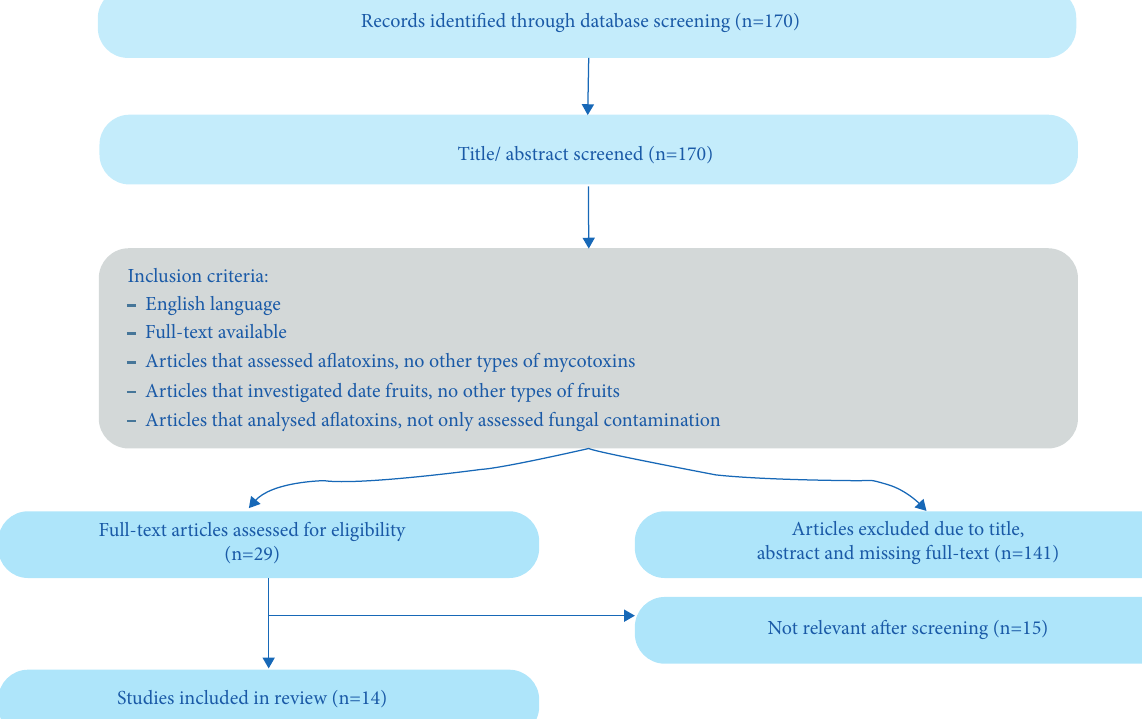
Figure 3: Flowchart indicating the search and selection process of